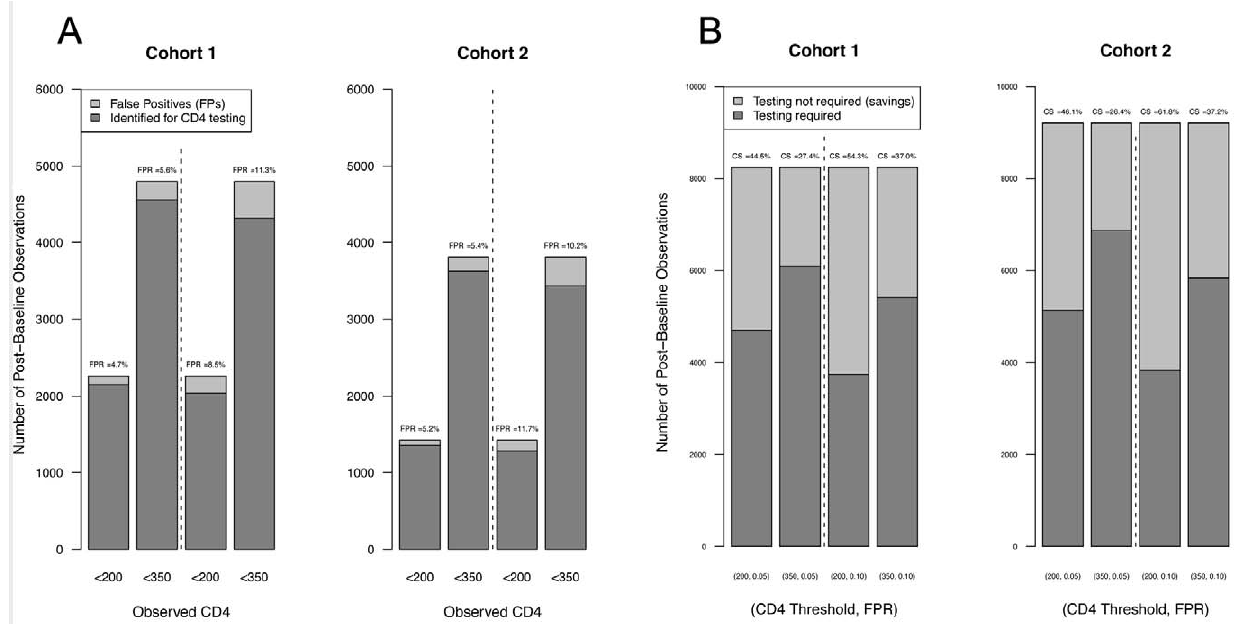
Figure 2. Summary of model performance. (A) Cross-validated estimates of FPRs. The bars represent the number of observed post-baseline observations below the thresholds indicated on the x- axis and at the indicated FPRs for Cohort 1 (left) and Cohort 2 (right). The dark shading indicates the number of observations correctly identified for laboratory-based CD4 testing (i.e., CD4 counts predicted to be and observed to be below threshold); lighter shading represents false positives (CD4 count incorrectly predicted as above threshold); cross-validated estimates of the FPRs are indicated above each bar. (B) Capacity savings (CS) estimates. Dark shading indicates the number of observations in Cohort 1 (left) and Cohort 2 (right) predicted to require laboratory-based CD4 testing (i.e., CD4 count predicted to be below threshold), and light shading the number of observations predicted to not require laboratory testing (i.e., CD4 count predicted to be above threshold) at the CD4 count threshold and FPR indicated below each bar.